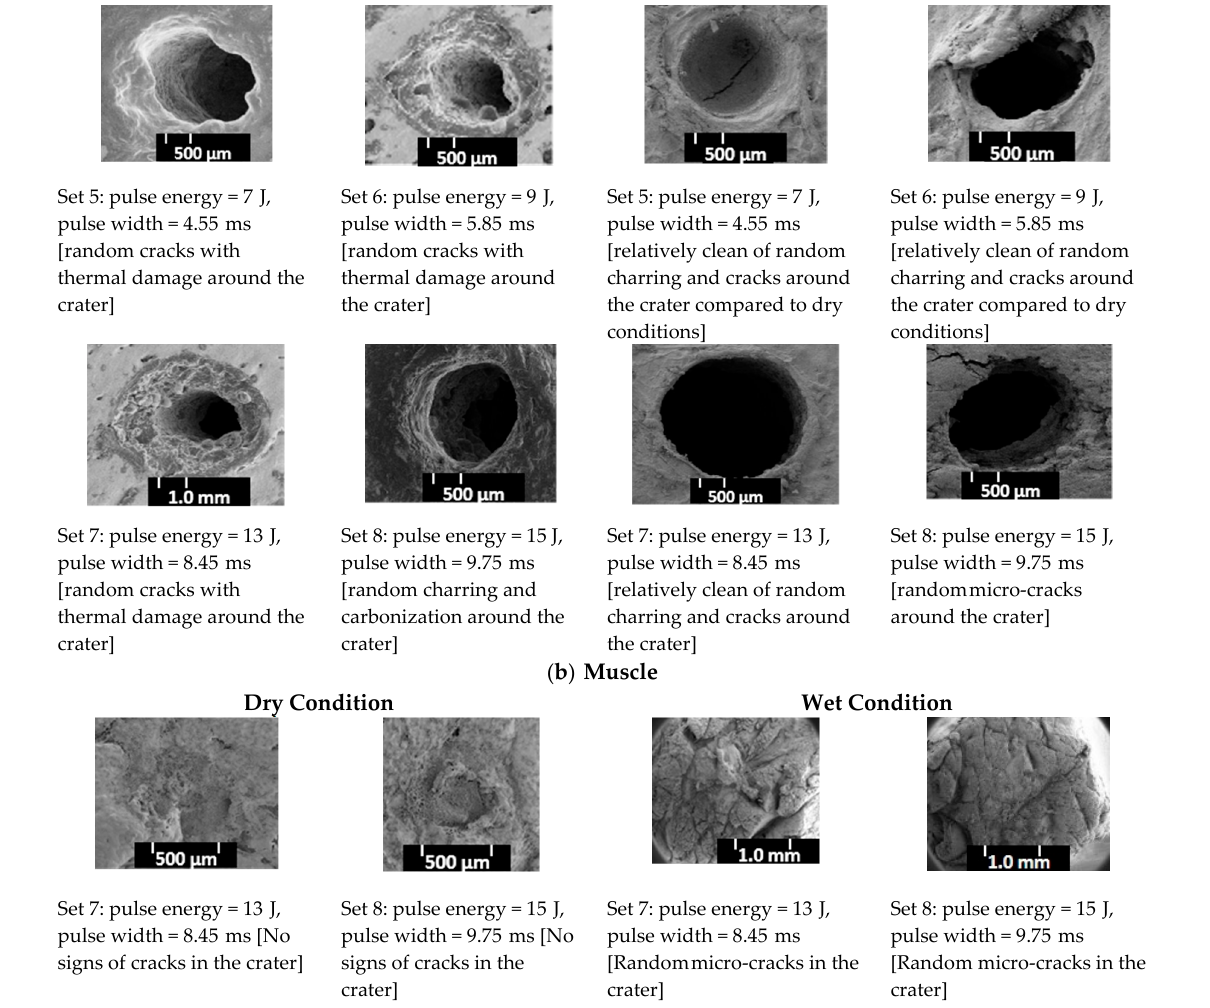
Figure 4. SEM top-views of ( a ) bone and ( b ) muscle surfaces in the dry and spray ablation after ten laser pulses.